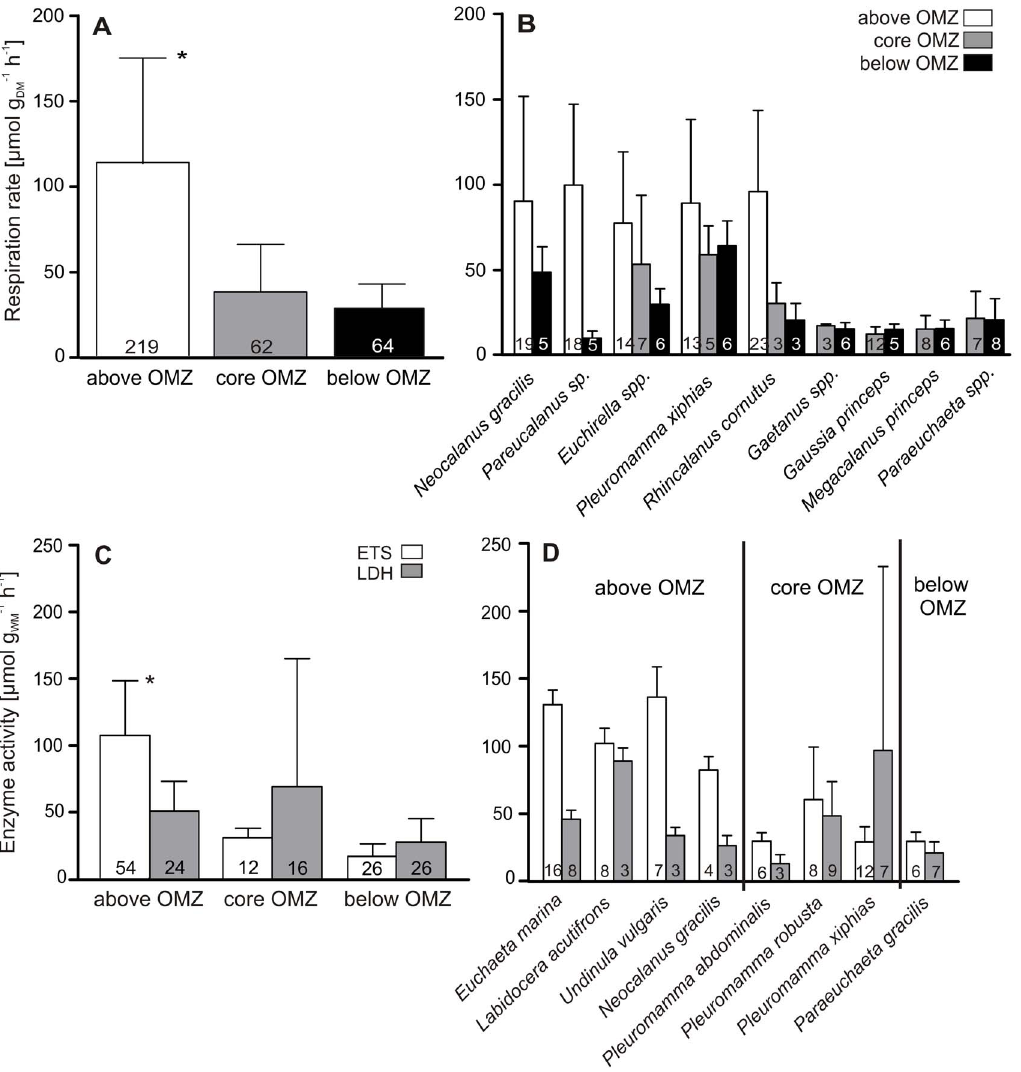
Figure 5. Metabolic rates of calanoid copepods in relation to the oxygen minimum zone (OMZ). A, mass-specific respiration rates. B, comparison of mass-specific respiration rates of nine copepod species (copepodids 5 + adults) from different depths. C, enzyme activities of the electron transport system (ETS) and the lactate dehydrogenase (LDH). D, comparison of enzyme activities of eight copepod species (copepodids 5 + adults) from different depths. Bars represent means with standard deviation: the number of measurements (n) is indicated in each bar. *=significantly higher respiration rate and ETS activity above the OMZ as compared to the core and below the OMZ.